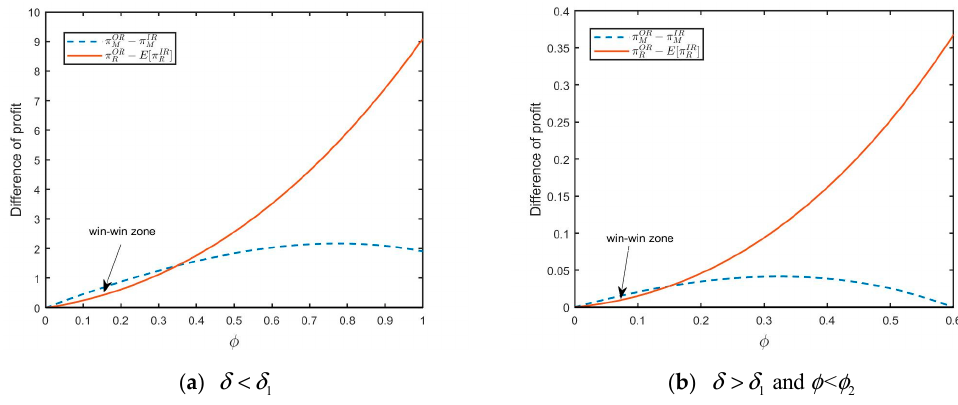
Figure 5. Win–win zone ( µ 2 = 0.3, σ 2 = 0.23) with ( a ) δ = 0.15 and ( b ) δ = 0.3.